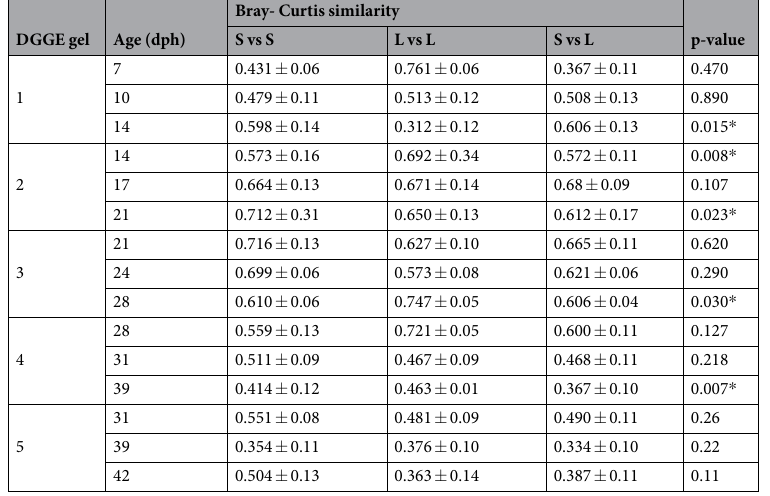
Table 2. Average Bray-Curtis similarities ( ± SE ) from comparison of the microbiota of equally old small (S) or large (L) larvae (within groups) and comparison of small and large larvae (between groups; S vs L), together with p-values from PERMANOVA for comparison of bacterial community composition of small and large larvae at different ages. Five S and five L individuals are included at all developmental stages. * Indicate p < 0.05.